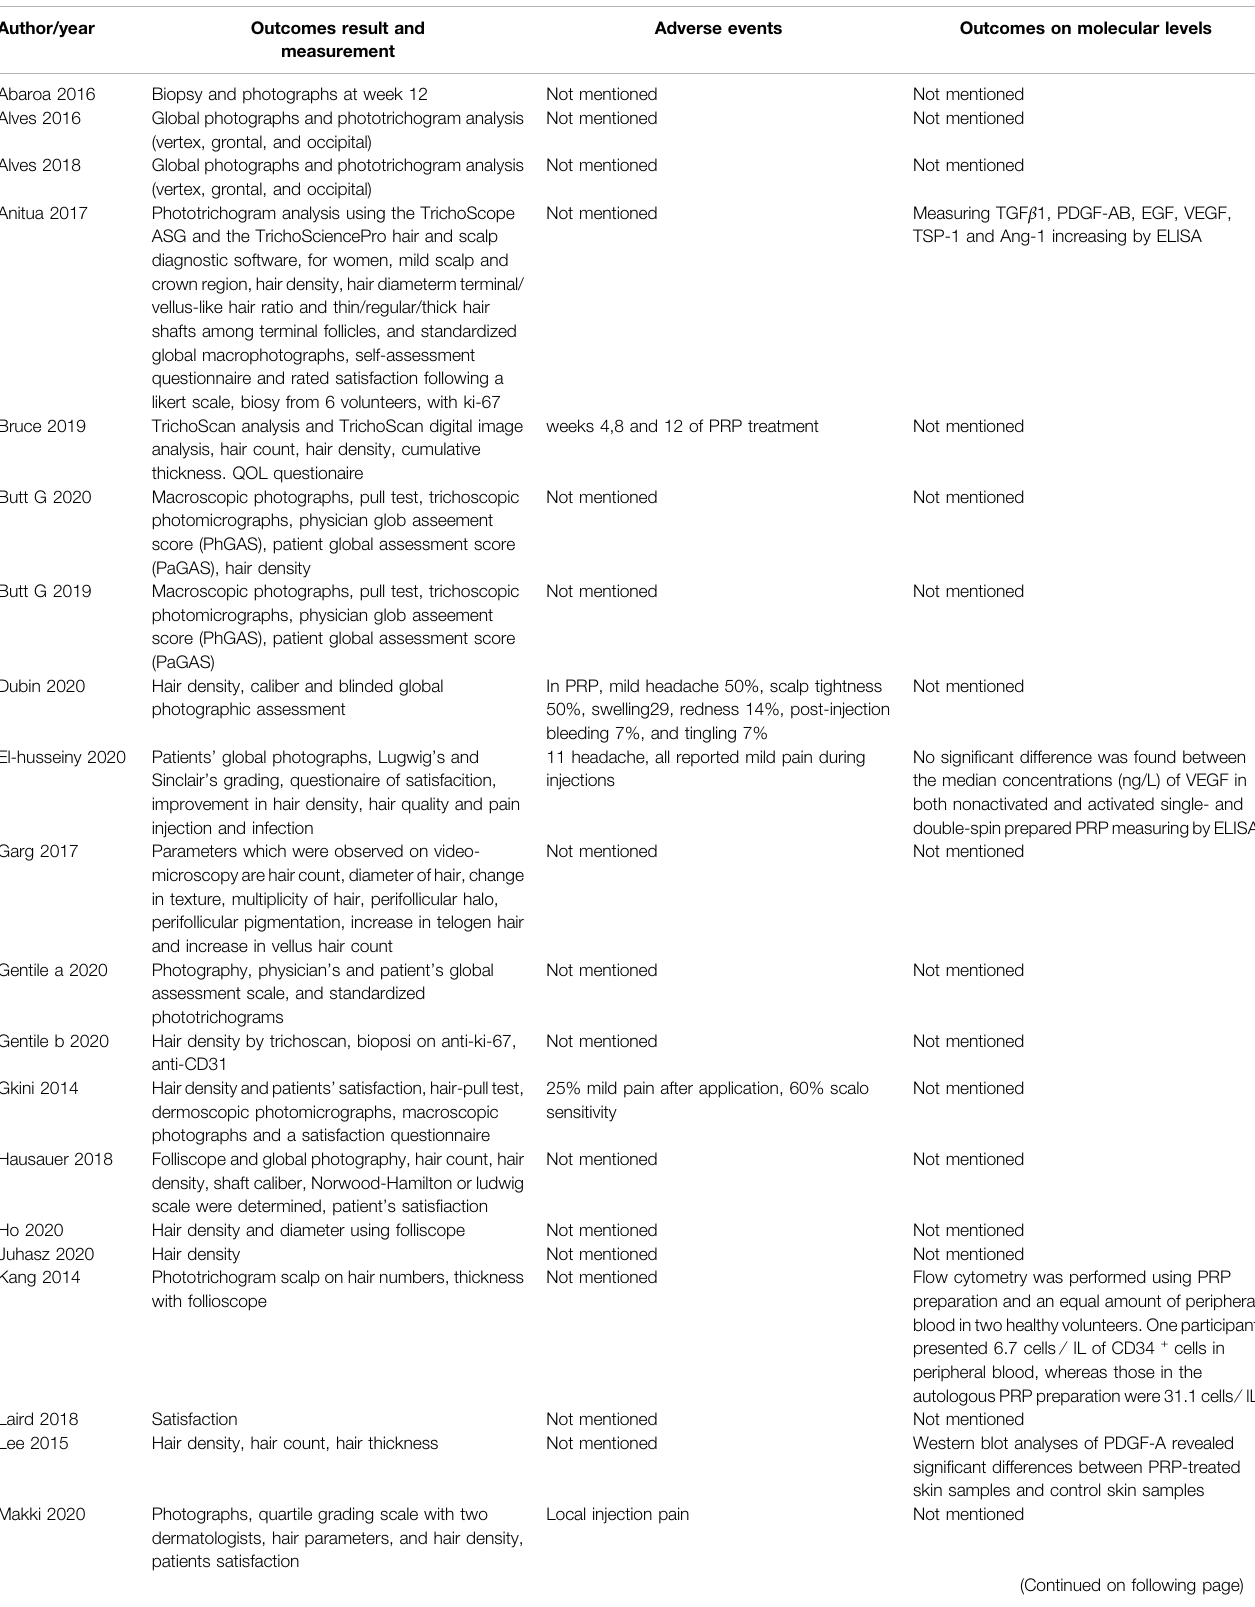
TABLE 4 | Outcomes measurement and adverse events in enrolled studies, and the evaluation of growth